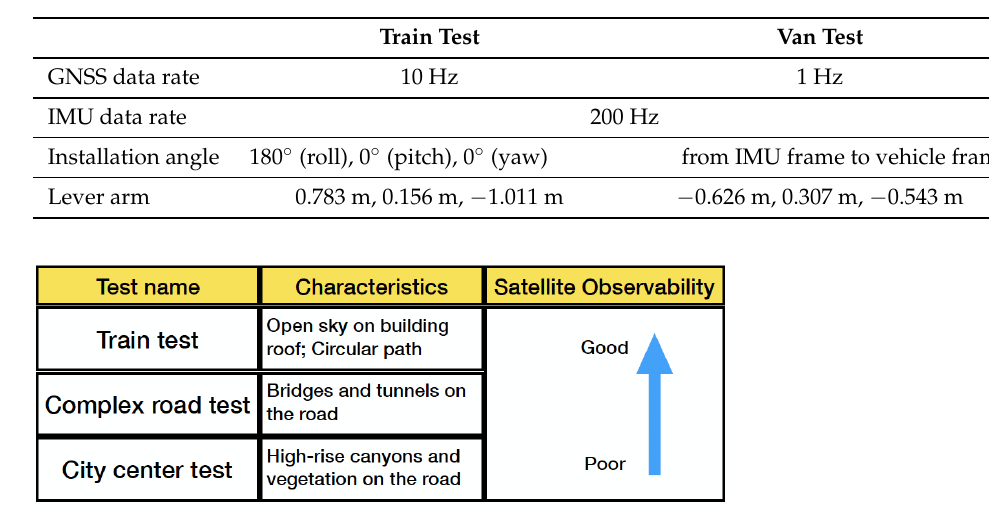
Figure 3. Trajectories of two van positioning tests. Table 1. Sensor sampling rates, lever arm, and installation angles from the two tests.